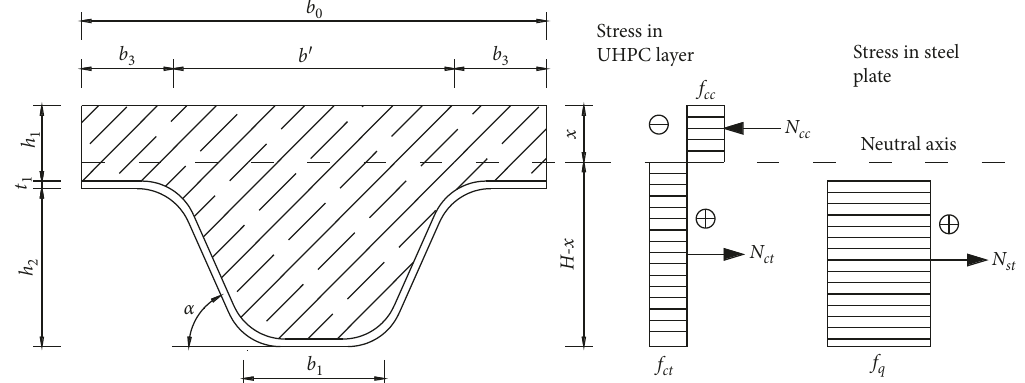
Figure 1: Bending performance of the corrugated steel Plate-UHPC composite bridge deck (scenario